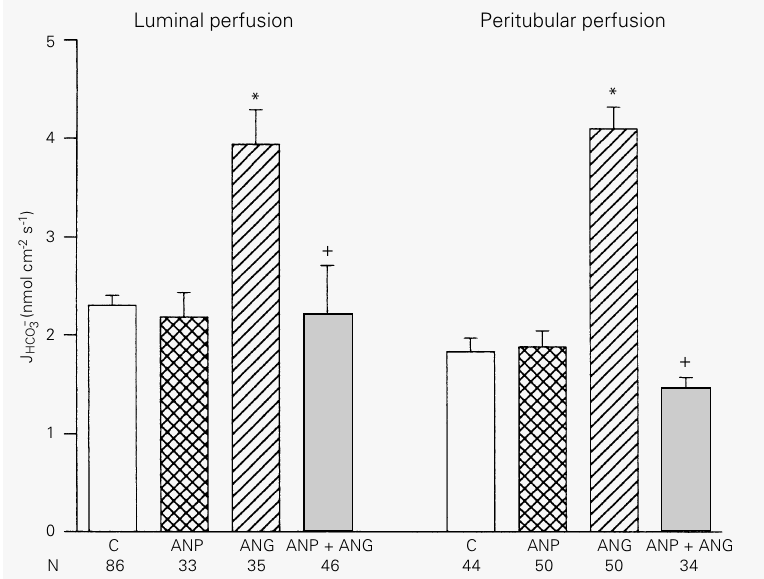
Figure 1 - Effect of atrial natriuretic peptide (ANP, 1 (cid:181)M) and/or angiotensin II (ANG, 1 pM)